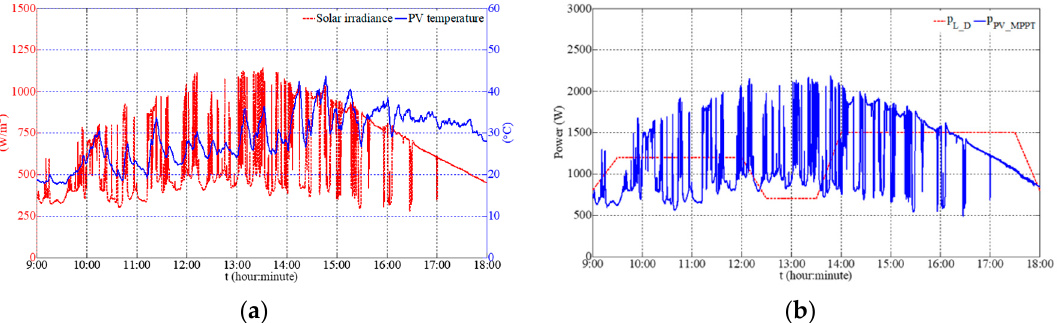
Figure 8. ( a ) Solar irradiance and PV cell temperature and ( b ) Load power demand and PV MPPT power.